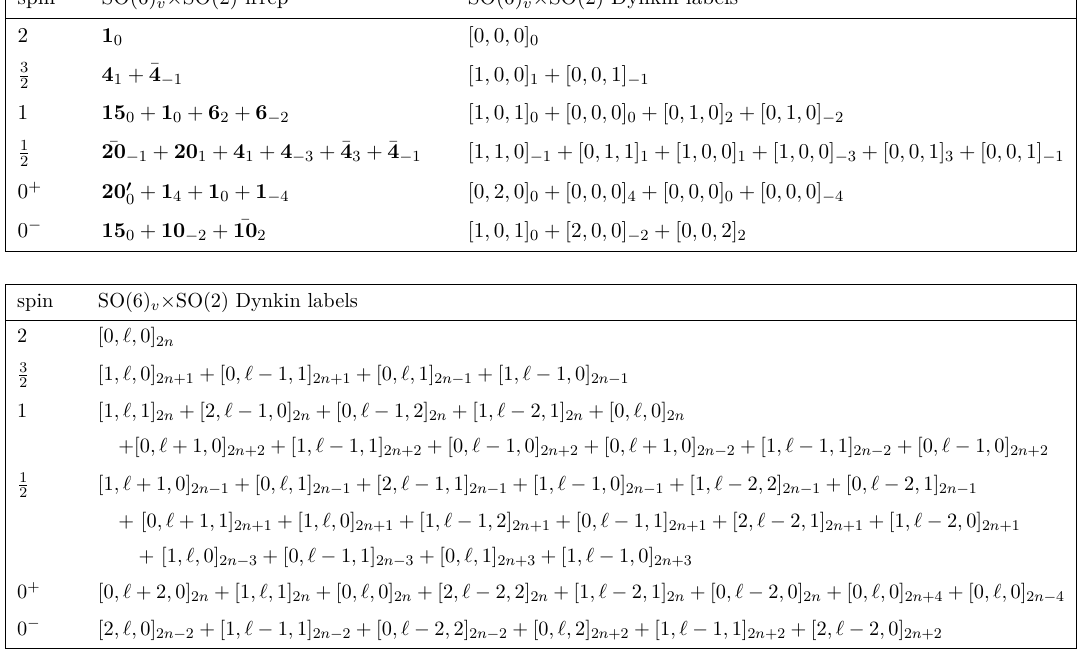
Table 2 . States in SO(6) v × SO(2) representations at KK levels ( ‘, n ) = (0 , 0) (above) and ‘ = 0 , 1 , 2 , . . . , n ∈ Z (below) in the KK towers for AdS 4 solutions of type IIB that uplift from D = 4 N = 8 [ SO (6) × SO (1 , 1)] n R 12 -gauged supergravity. SO(6) v representations are given in terms of SU(4) Dynkin labels, and SO(2) charges are given as subscripts. Representations with negative Dynkin labels are absent and need to be crossed out. For a solution with residual symmetry G ⊂ SO (6) v , the spectrum organises itself in the representation of G that branch from these SO(6) v representations. The tables exclude some 0 + states of D = 4 supergravity that are always Higgsed